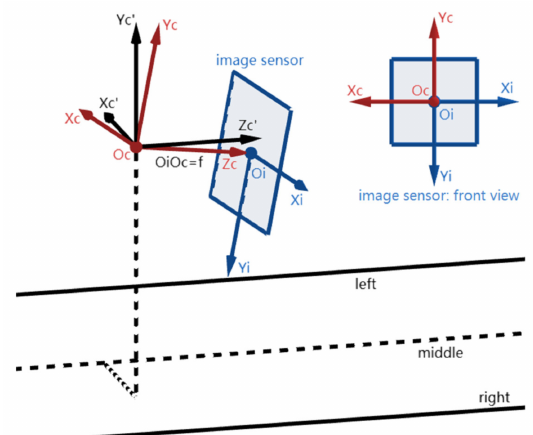
Figure 2. The positions of the three coordinate systems.